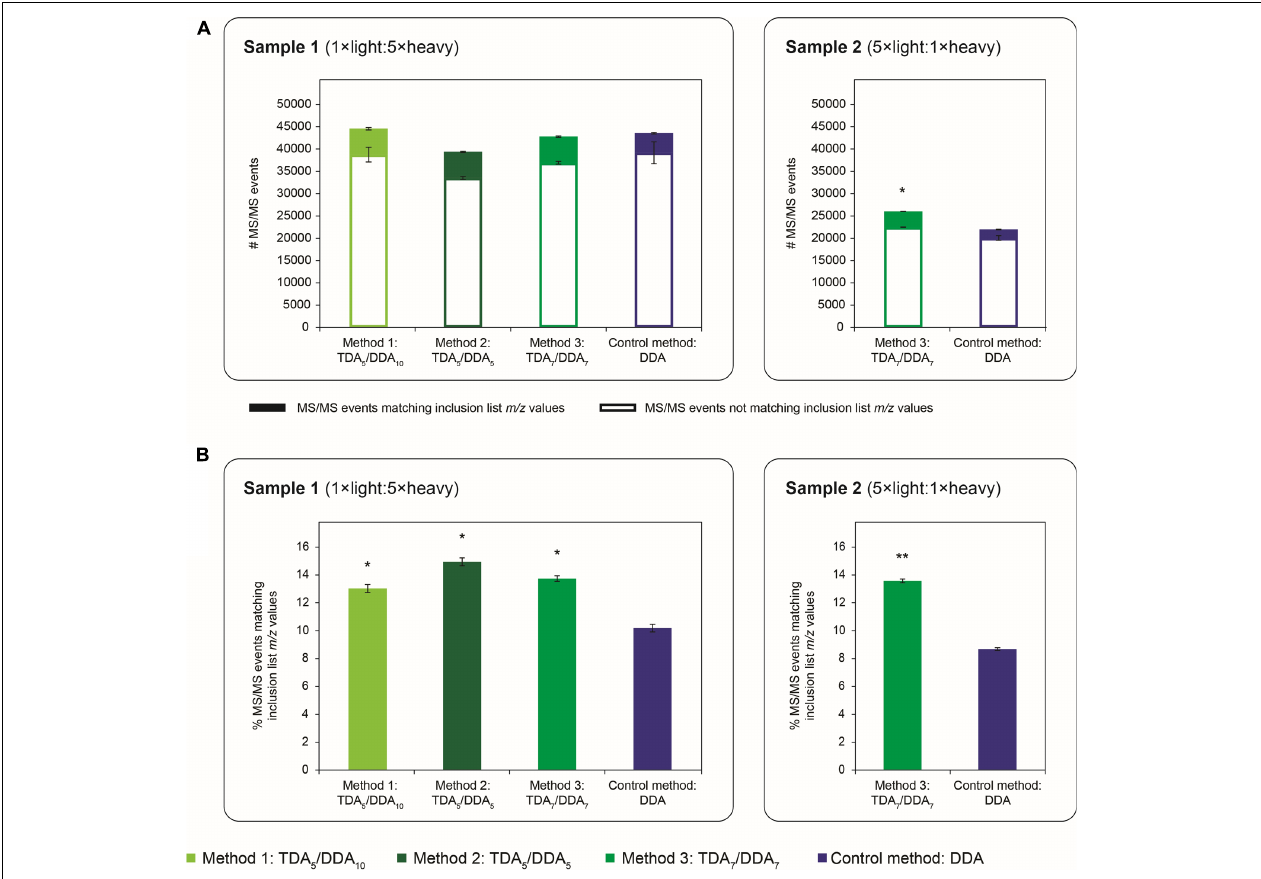
FIGURE 2 | Quantity of MS/MS events obtained in TDA/DDA and DDA control method experiments. (A) Average numbers of MS/MS events per technical replicate in each batch of LC-MS/MS experiments conducted on sample 1 (left) and sample 2 (right); MS/MS events matching inclusion list m/z values are differentiated from those that do not; standard errors are shown for these two categories of MS/MS events. (B) Average percentages of MS/MS events matching inclusion list m/z values per technical replicate in each batch of LC-MS/MS experiments conducted on sample 1 (left) and sample 2 (right). Statistically significant differences between TDA/DDA and DDA control method experiments, as determined using 2-tailed t -tests, are labeled ∗ p < 0.05 or ∗∗ p <